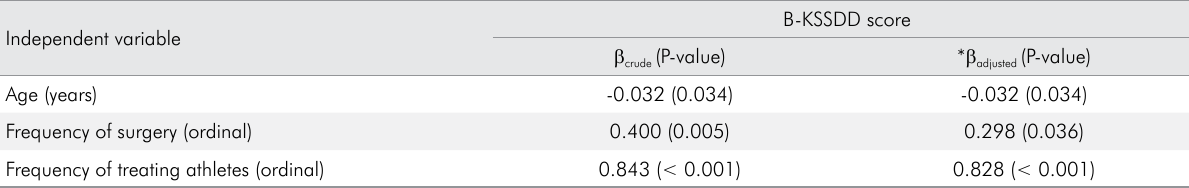
Table 4. Coefficients of the simple and multiple linear regression models for predicting knowledge about sports doping in